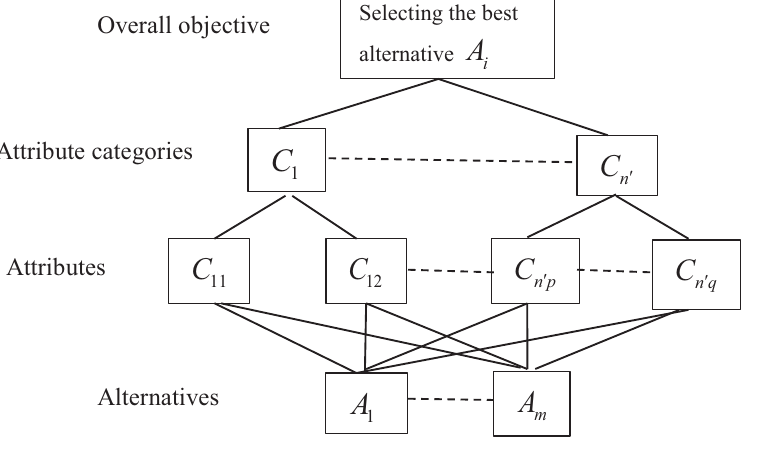
Figure 1. The hierarchical structure of a complex